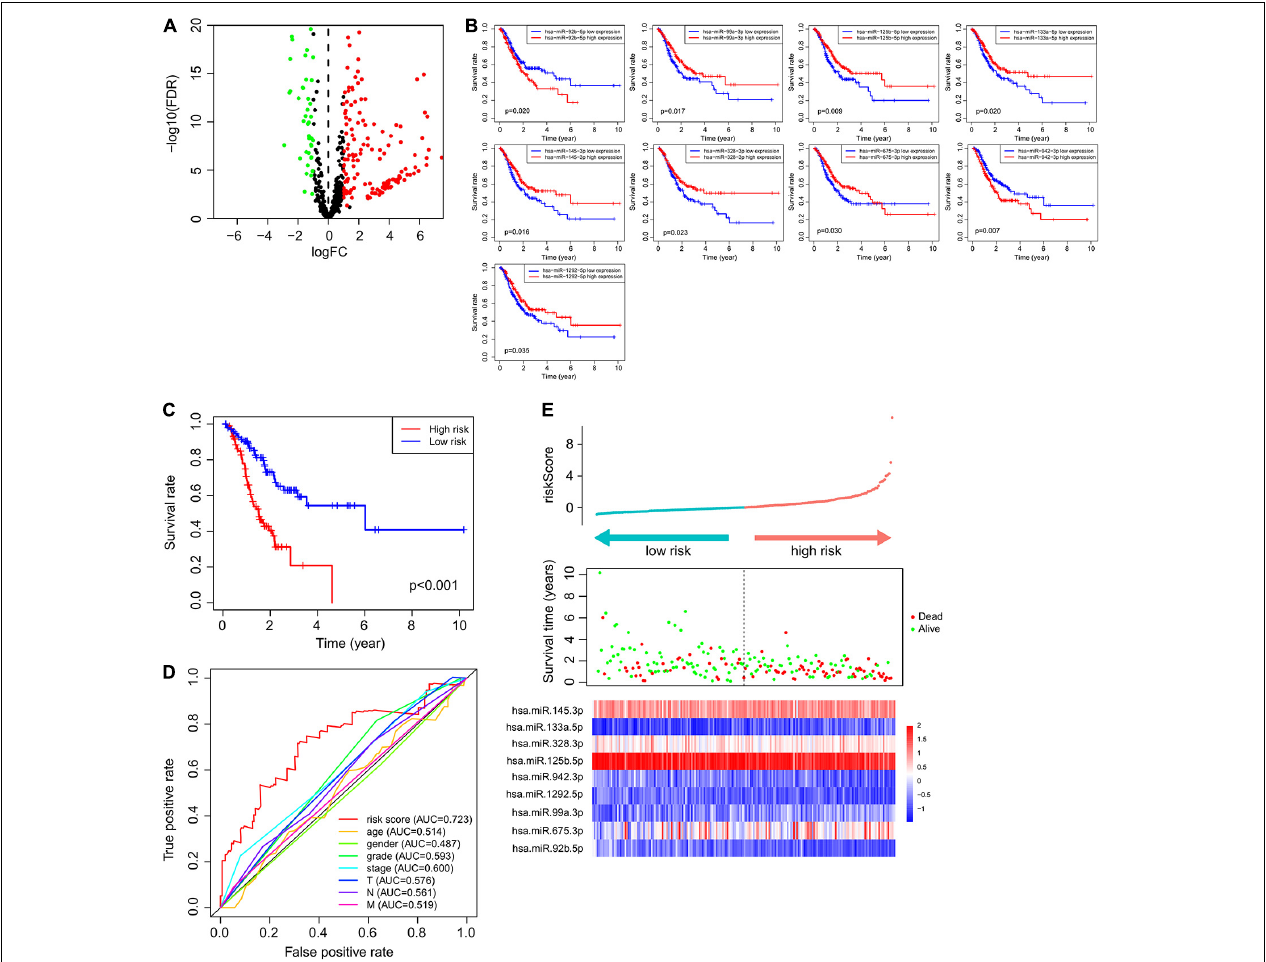
FIGURE 1 | Immune-related miRNAs associated with GC tumorigenesis and outcomes. (A) MicroRNAs with differential expression. Green bubbles represented downregulated microRNAs, and red bubbles represented upregulated microRNAs. (B) Kaplan–Meier survival curve of nine prognostic microRNAs. (C) Kaplan–Meier survival curve of patients in high- and low-risk groups. (D) ROC curve of ImmiRSig, age, gender, grade, stage, and T, N, M in the training cohort. (E) Risk score distribution, survival status, and microRNA expression patterns for patients in high- and low-risk groups by the ImmiRSig in training